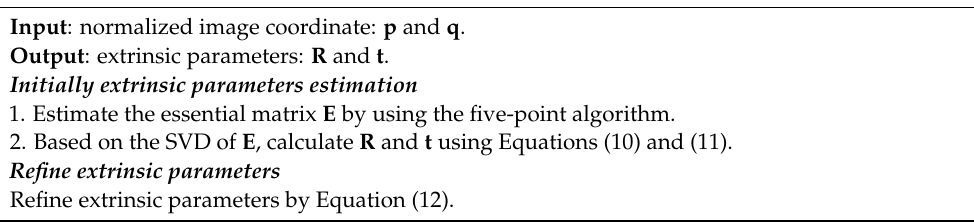
Algorithm 2. Determining extrinsic parameters from matched